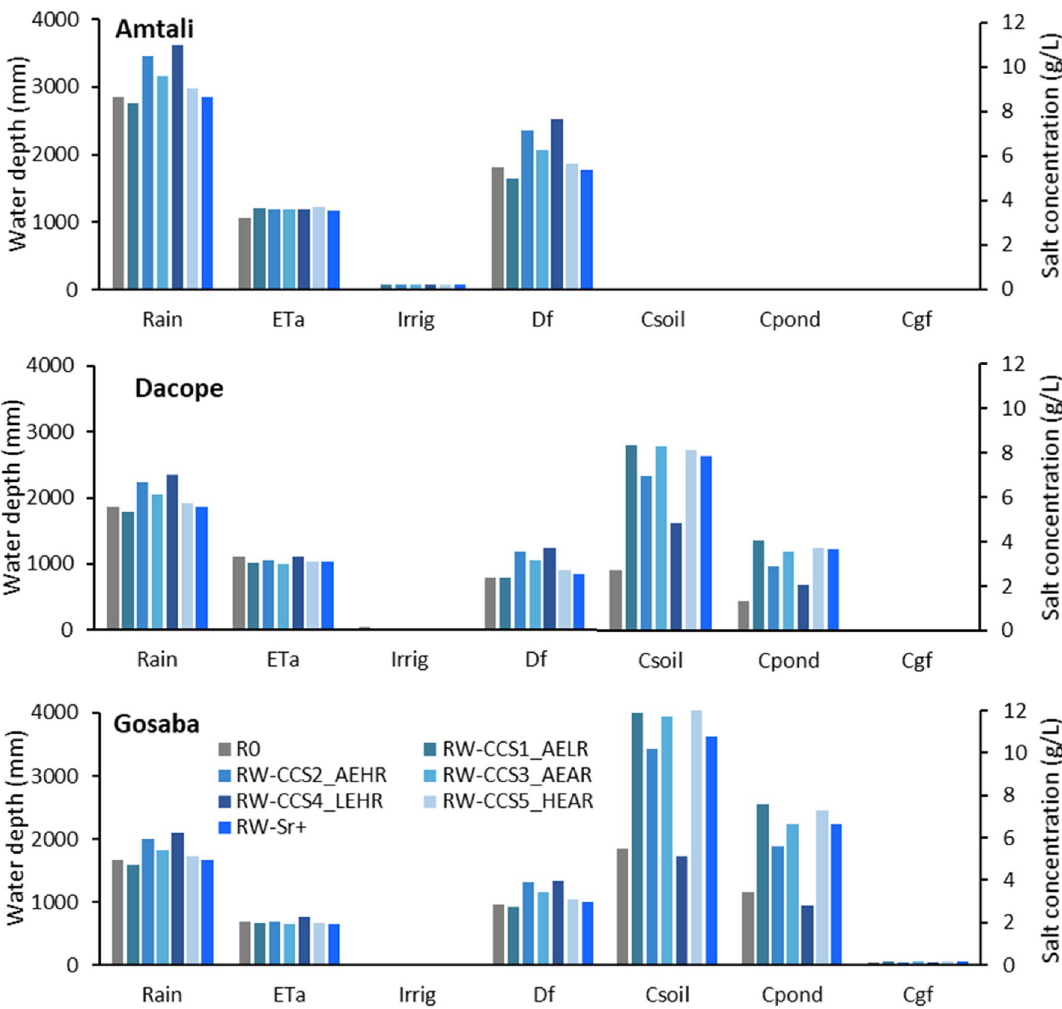
Figure 7. Comparison of water (left hand axis) and salt (right hand axis) balance under combined effects of land management and climate scenarios for the Amtali (top) and Dacope (middle) polders and Gosaba Island (bottom) (base case scenarios i and scenarios xii to xvii).